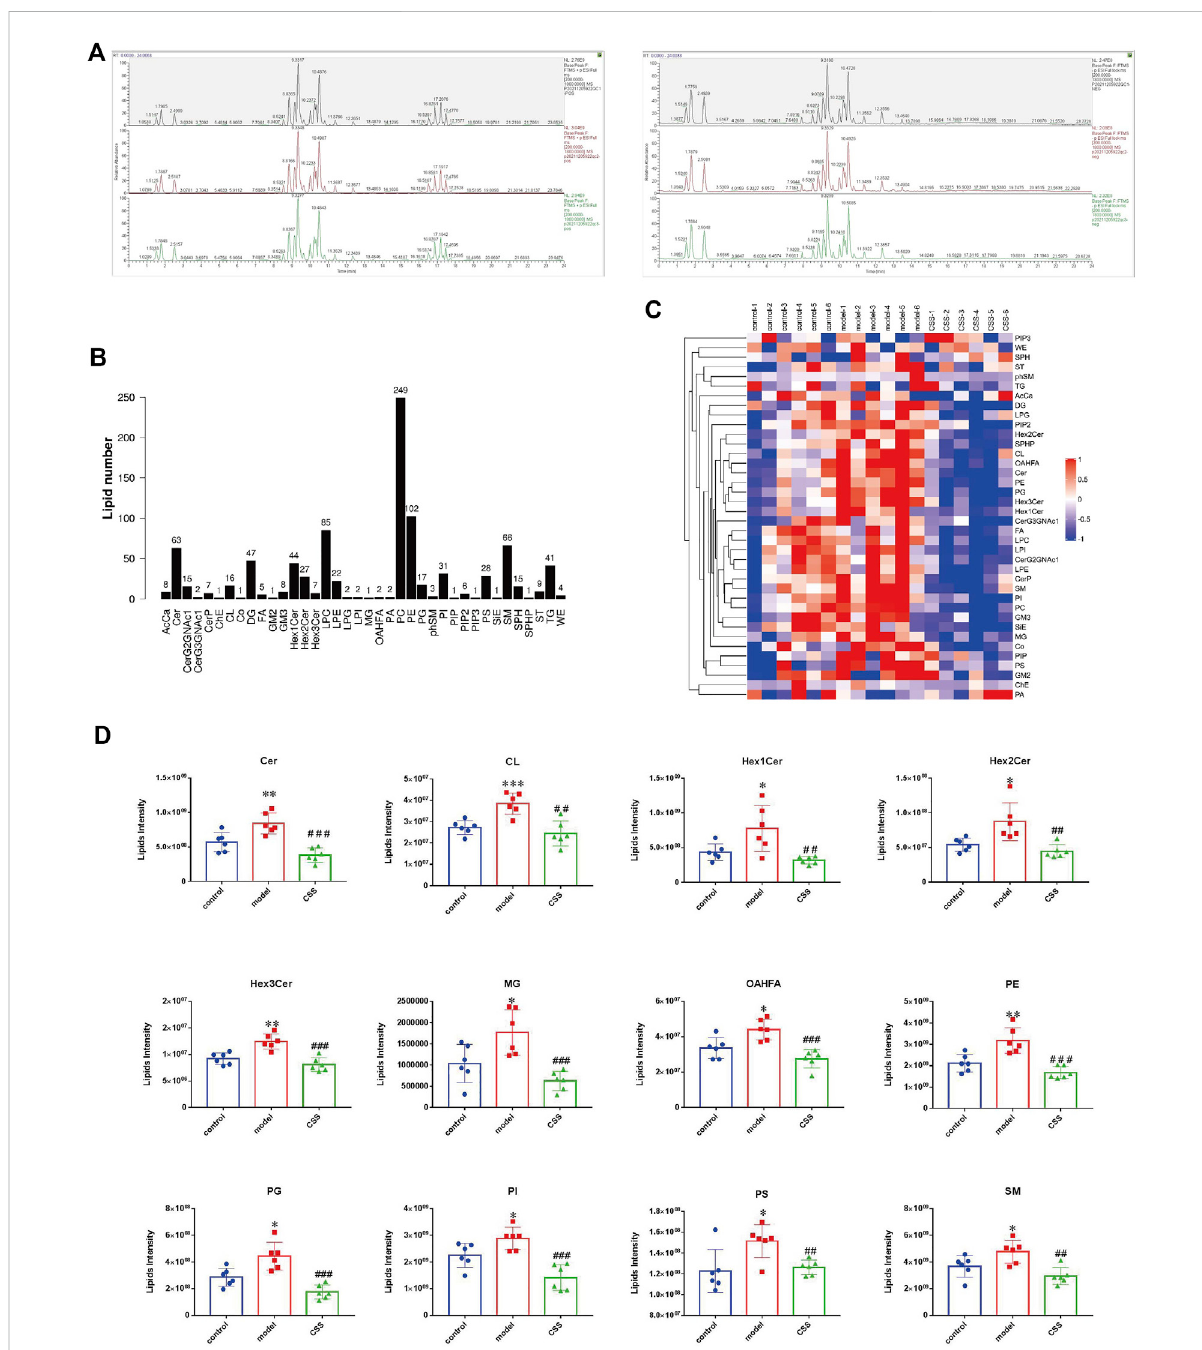
FIGURE 3 Ion analyses revealed the composition and change of lipid class. (A) The Total ion chromatograms (TIC) under positive and negative ion modes. Metabolomics showed very stable performance as chromatograms were anastomotic in positive ion and negative ion models. (B) Lipid subgroup and lipid moleculecountaccordingtotheInternationalLipidClassi fi cationandNomenclatureCommittee. (C) Differentconsistenceoflipidclassincontrol,modeland CSS groups. (D) The 12 lipid classes with opposite trends in model vs. control ( p < 0.05) and CSS vs. model ( p < 0.05). AcCa, Acyl Carnitine; Cer, Ceramides; CerG2GNAc1, N-acetylhexosyl ceramide; CerG3GNAc1, Dihexosyl N-acetylhexosyl ceramide; CerP, Ceramides phosphate; ChE, Cholesterol Ester; CL, Cardiolipin; Co., Coenzyme Q; DG, Diglyceride; FA, Fatty Acid; GM2, Ganglioside, monosialo dihexosyl ceramide; GM3, Ganglioside, monosialo trihexosyl ceramide; Hex1Cer/Hex2Cer/Hex3Cer, Hexosyl ceramide; LPC, Lysophosphatidylcholine; LPE, lysophosphatidylethanolamine; LPG, Lysophosphatidylglycerol; LPI, Lysophosphatidylinositol; MG, Monoglyceride; OAHFA, (O-acyl)-1-hydroxy fatty acid; PA, Phosphatidic Acid; PC, Phosphatidylcholine; PE, Phosphatidylethanolamine; PG, Phosphatidylglycerol; phSM, Phytosphingosine; PI, Phosphatidylinositol; PIP, Phosphatidylinositol (4) phosphate; PIP2, Phosphatidylinositol (4,5) bisphosphate; PIP3, Phosphatidylinositol (3,4,5) triphosphate; PS, Phosphatidylserine; SiE, Sitosterol ester; SM, Sphingomyelin; SPH, Sphingosine; SPHP, Sphingosine phosphate; ST, Sulfatide (galactosyl ceramide sulfate); TG, Triglyceride; WE, Wax